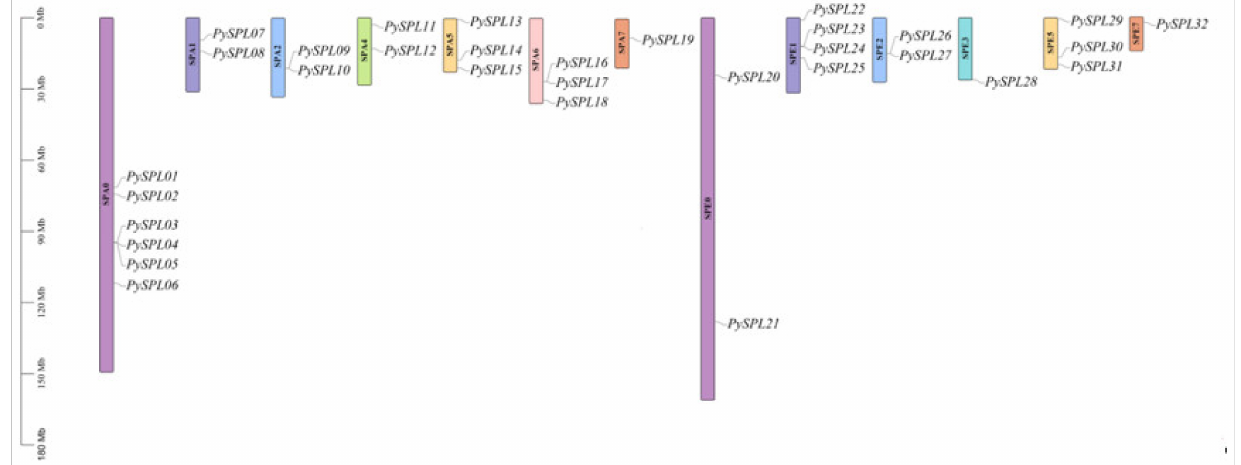
Figure 1. Chromosomal localization of PySPLs in Prunus × yedoensis ‘Somei-yoshino’. The chro- mosome number is marked in the middle of each chromosome. The scale is in Mega-bases (Mb). Chromosome pairs are marked with the same